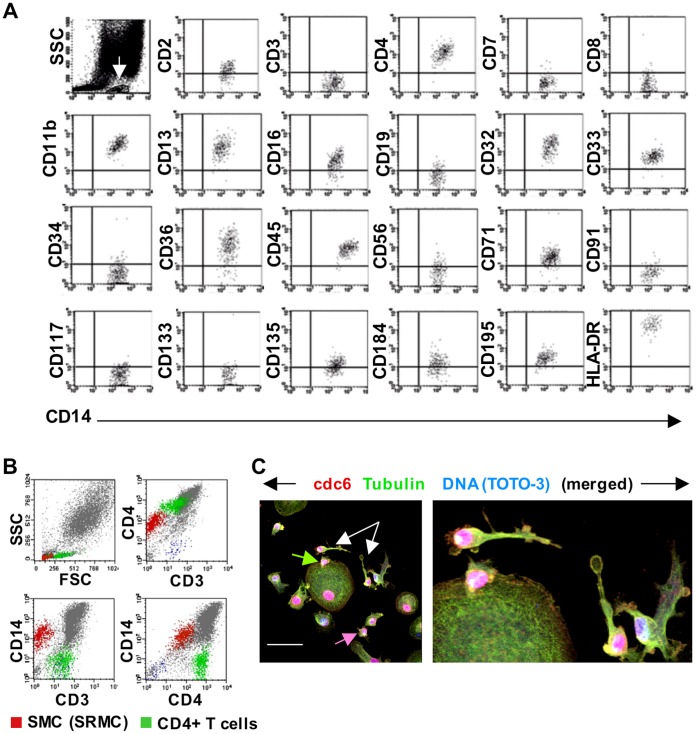
Characteristics of small monocytoid cells produced by nurse macrophages.(A) Immunophenotype of nonadherent small monocytoid cells (SMC) harvested from an 18-day-old MDM culture. White arrow (top left plot) identifies the gated population shown in other plots. (B) Forward scatter (FSC) versus side scatter (SSC) plot demonstrates that SMC (CD3negCD4dimCD14+) are smaller than resting lymphocytes. Cells from 17-day-old MDM. Analysis performed using Paint-a-Gate software. (C) Confocal microscopy demonstrating that SMC adhere following their exit from nurse macrophages. Shown here is an 18-day-old primary MDM culture. An SMC adhering to a large macrophage (green arrow) and another adhering to the culture dish (pink arrow) can be seen. Others with elongated processes are also visible (white arrows) and viewable in greater detail in the panel on the right. The pink color of the nuclei reflects cdc6 colocalization with DNA as identified by TOTO-3 staining. SMC nuclei are typically cdc6+ during and shortly after budding from nurse macrophages, reflecting recent DNA synthesis. Size bar: 50 µm.